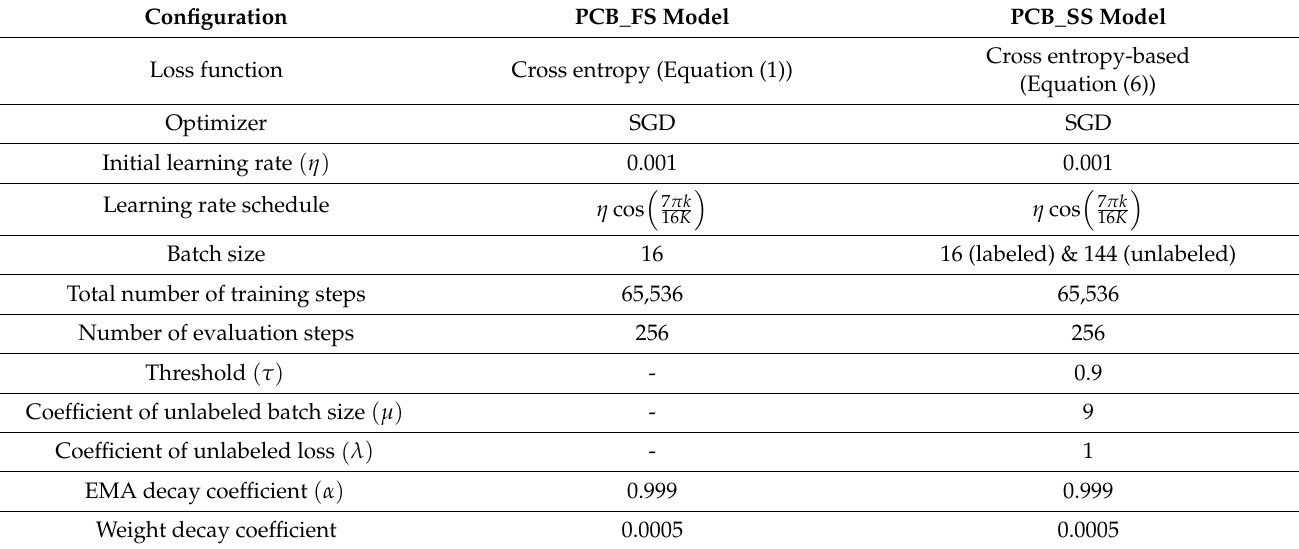
Table 4. Hyperparameter configuration for the training